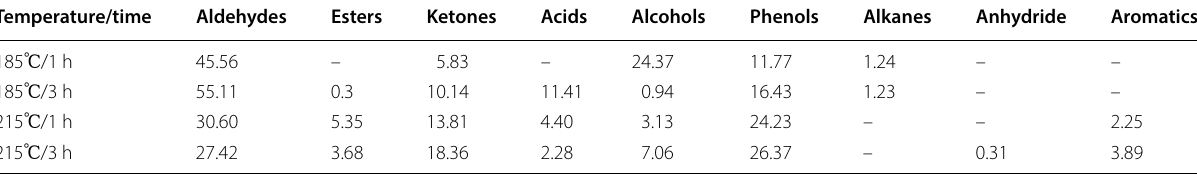
Table 2 Relative amounts of the effluents condensated by VOCs of rubberwood from different heat-treatment technological